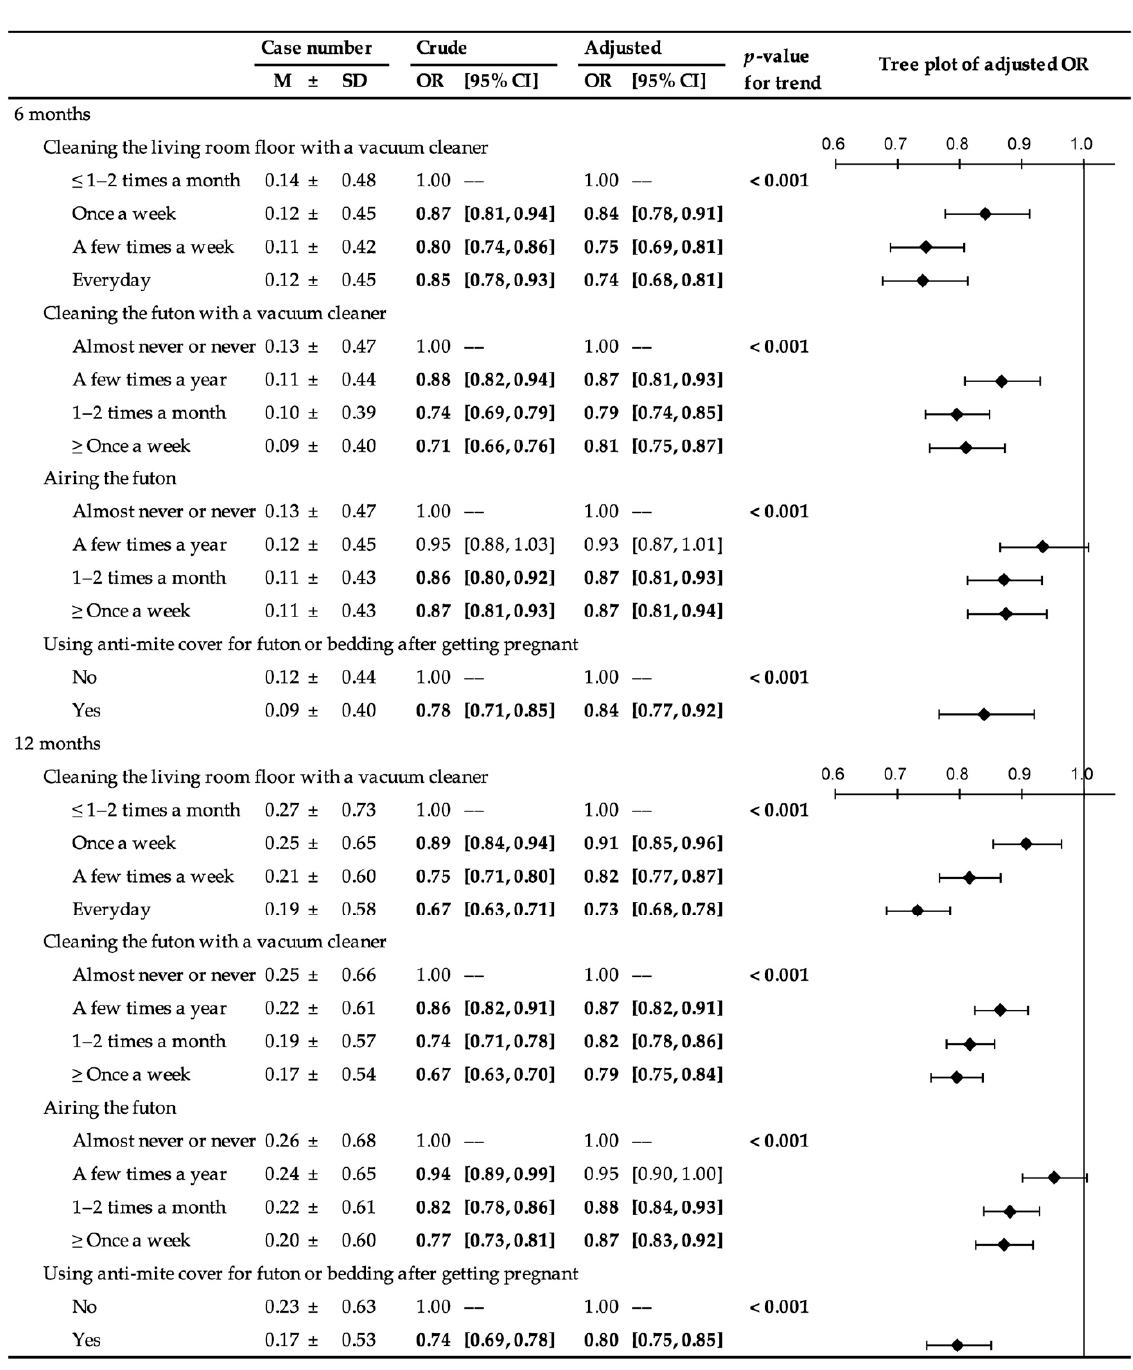
Figure 2. Total number of screen-positive cases over the five developmental areas in the ASQ-3 (case number) and their odds ratios according to the exposure variables (based on imputed data for the 81,106 infants in this study). Boldface indicates statistical significance at the level of 5%. OR, odds ratio; CI, confidence interval; ASQ-3, Ages and Stages Questionnaire, Third Edition. Crude = crude model. Adjusted = model adjusted for maternal age, body mass index, parity, history of allergy, psychological distress, smoking status, alcohol intake, number of hours spent outdoors, physical activity, folic acid intake, marital status, highest educational level, employment status, annual household income, type of residence, number of rooms in the house or apartment, living room flooring material, having a pet, usage of air purifiers, age of house or apartment building, house renovation or interior completion after becoming pregnant, and number of years living in the current place of residence. p -values for trend were calculated for adjusted models.